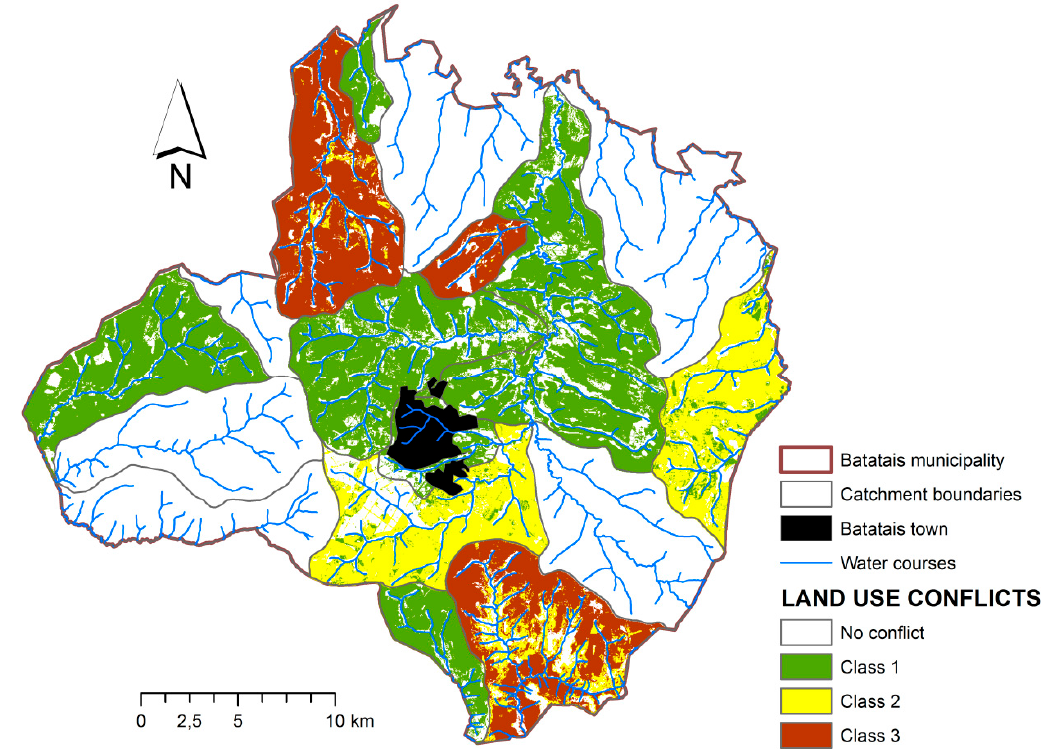
Figure 6. Map of land use conflicts within the Batatais municipality. Table 6. Cross-classification of land use conflict and flood vulnerability in the municipality of Batatais SP. The grey shaded cells represent concern situations because they combine medium to very high flood vulnerability and land use conflict.